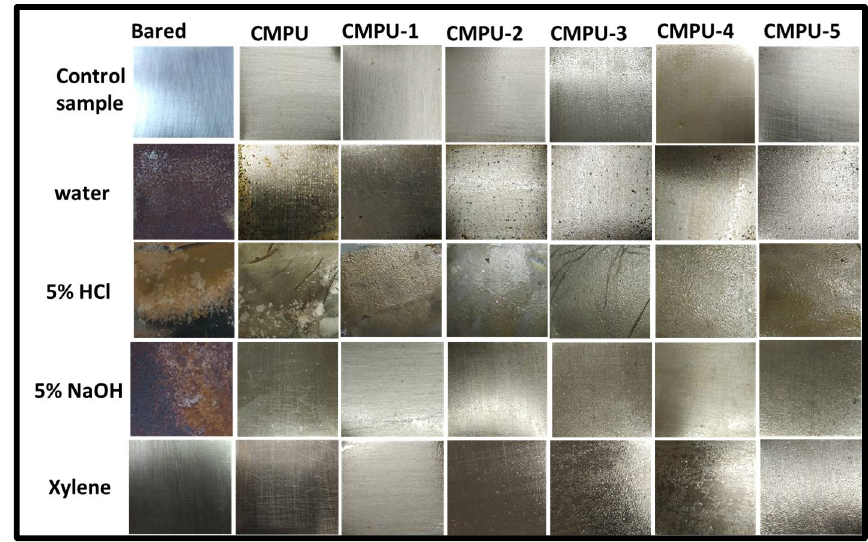
Figure 6. Chemical resistance of bared and prepared PU coatings.